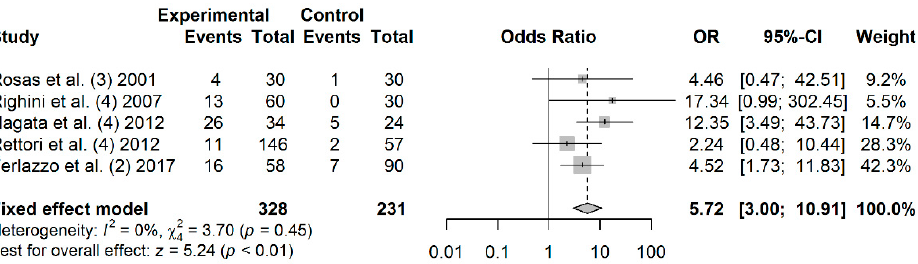
Figure 4. Forest plot for the association between DAPK promoter hypermethylation and HNC risk. The squares represent the ORs for individual studies. Bars represent the 95% CIs. The center of the diamond represents the summary effect size. 3.8. Association between TIMP3 Promoter Hypermethylation and HNC Risk A total of 328 cases and 236 controls from 4 studies were included to estimate the effect of TIMP3 promoter hypermethylation on HNC risk. As shown in Figure 5, a signif- icant association was found between salivary TIMP3 promoter hypermethylation and HNC risk (OR: 3.42; 95% CI = 1.99–5.88). Visual inspection of the funnel plot revealed a symmetrical distribution of the studies (Begg’s test, p = 0.174; Egger’s test, p = 0.419), indi- cating no evidence of publication bias (Figure S5).